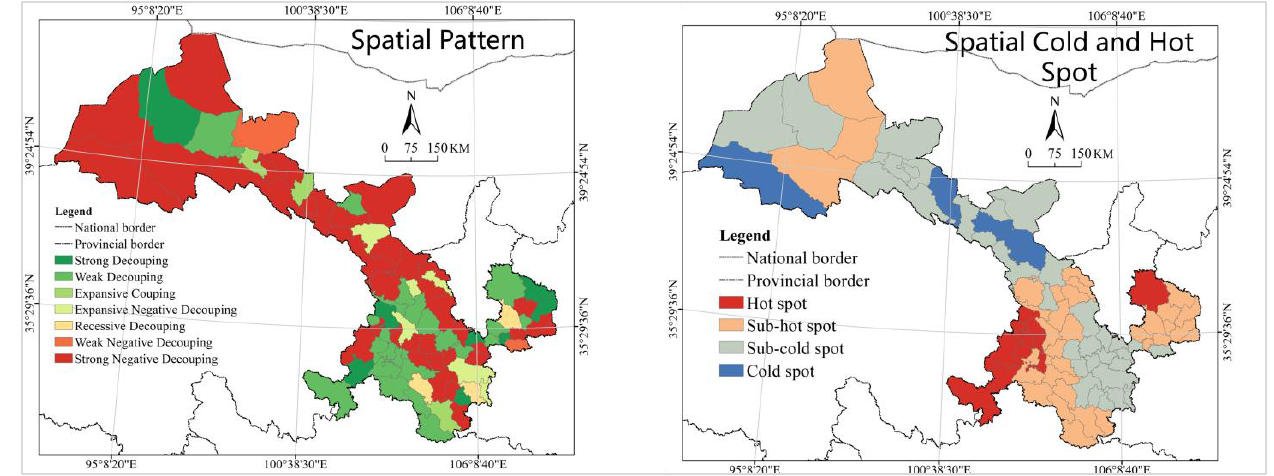
Figure 9. Statistical analysis of decoupling results in Gansu.